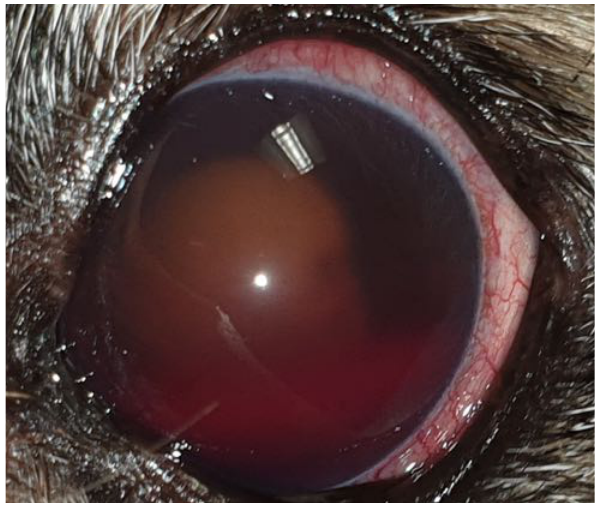
Figure 3. Uveitis, Border terrier, 7yo, MN- note the diffuse conjunctival hyperaemia, mid-dilated pupil, hyphaema, hypermature cataract (North Downs Specialist Referrals)